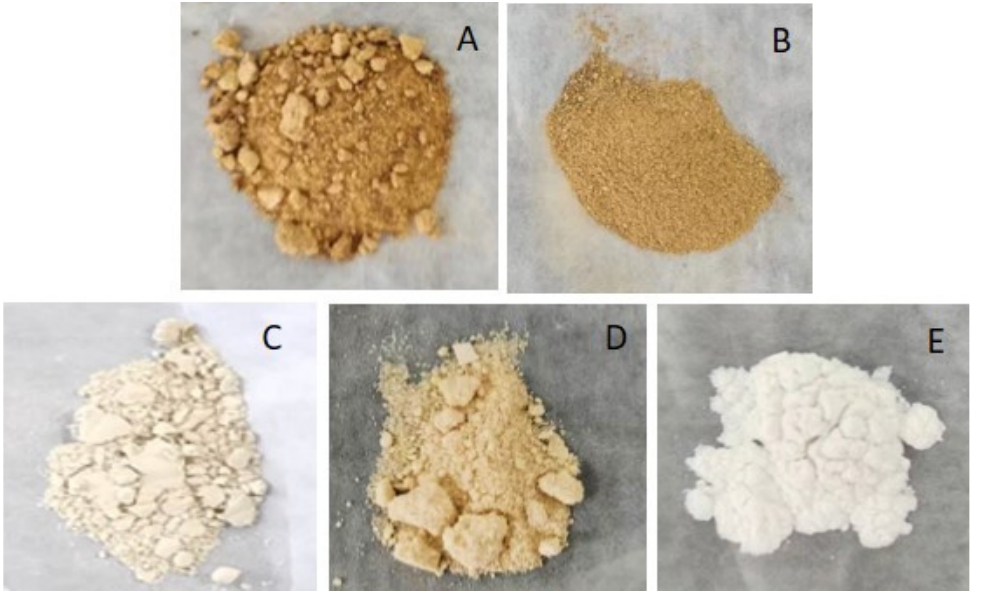
Figure 2. The images of IHRPs purified by different methods: ( A ) sevage method; ( B ) 500 Da membrane filtration; ( C ) column chromatography; ( D ) 4% activated carbon adsorption; ( E ) 8% activated carbon adsorption. Table 4. Polysaccharide/protein contents of IHRPs purified by column